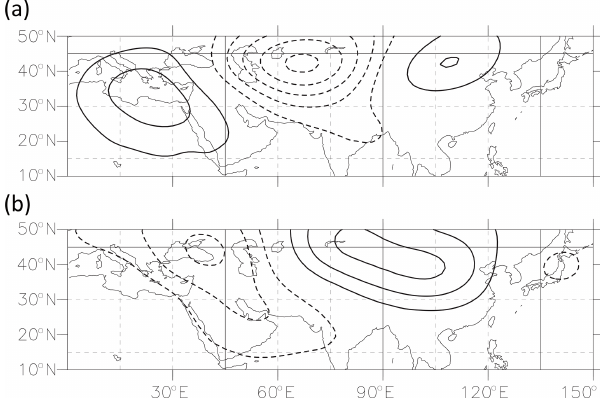
Figure 7. Spatial structure of (a) EOF1 and (b) EOF2 modes in geopotential height. The contour interval is 6m. Zero contours are suppressed.